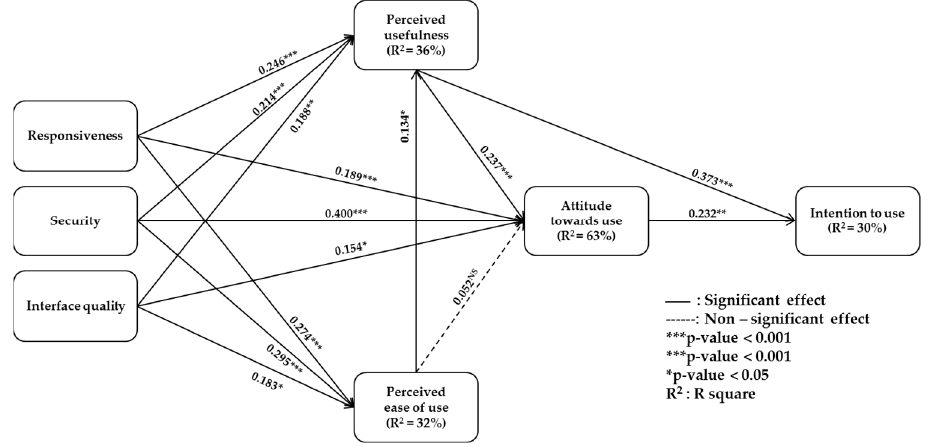
Figure 2. SEM model.